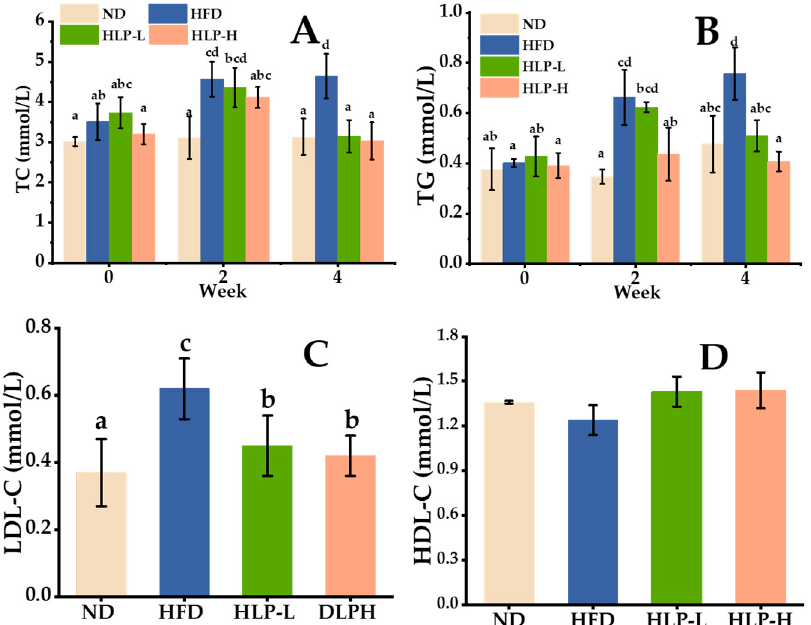
Figure 1. Effect of Holothuria leucospilota polysaccharides (HLP) on serum total cholesterol (TC) ( A ), triglyceride (TG) ( B ), low-density lipoprotein cholesterol (LDL-C) ( C ) and high-density lipoprotein cholesterol (HDL-C) ( D ). Data are presented as means ± standard error of the mean (SEM) ( n = 8); values with different superscripts represent significant differences ( p < 0.05).